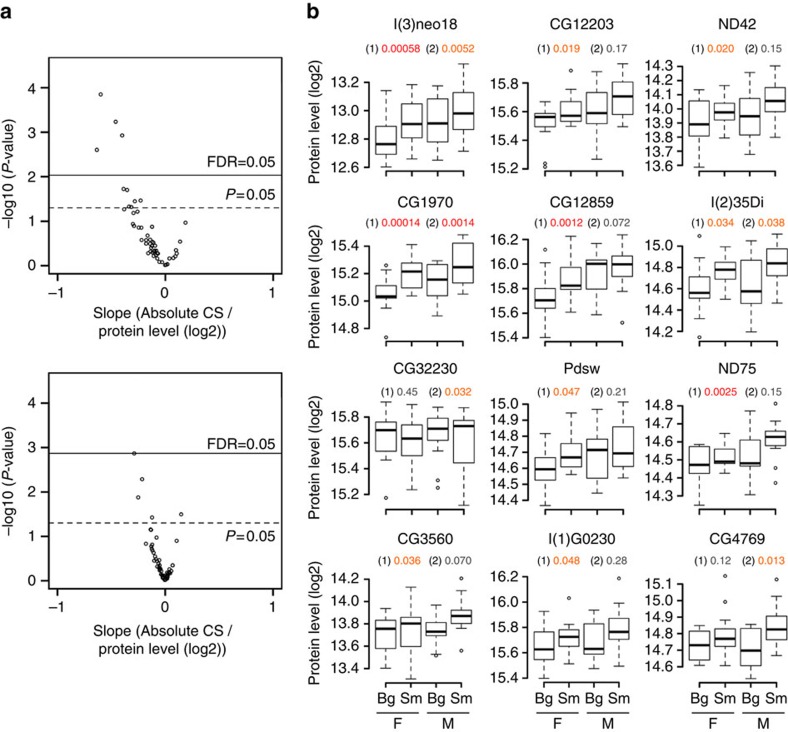
System-level negative association of mitochondrial respiration with wing size.(a) Negatively biased slope distribution of mitochondrial respiratory chain complex proteins. The P-values obtained in PWAS for absolute and relative CSs are plotted against slopes fitted in the model. The horizontal lines indicate significance thresholds as indicated. (b) Levels of mitochondrial respiratory chain complex proteins associated with wing size are plotted against wing size for each sex. P-values are shown for association with absolute CS (1) and relative CS (2). Significance levels of association are indicated by colour of P-values as in Fig. 4b. Bg, big wing samples; F, female; M, male; Sm, small wing samples.